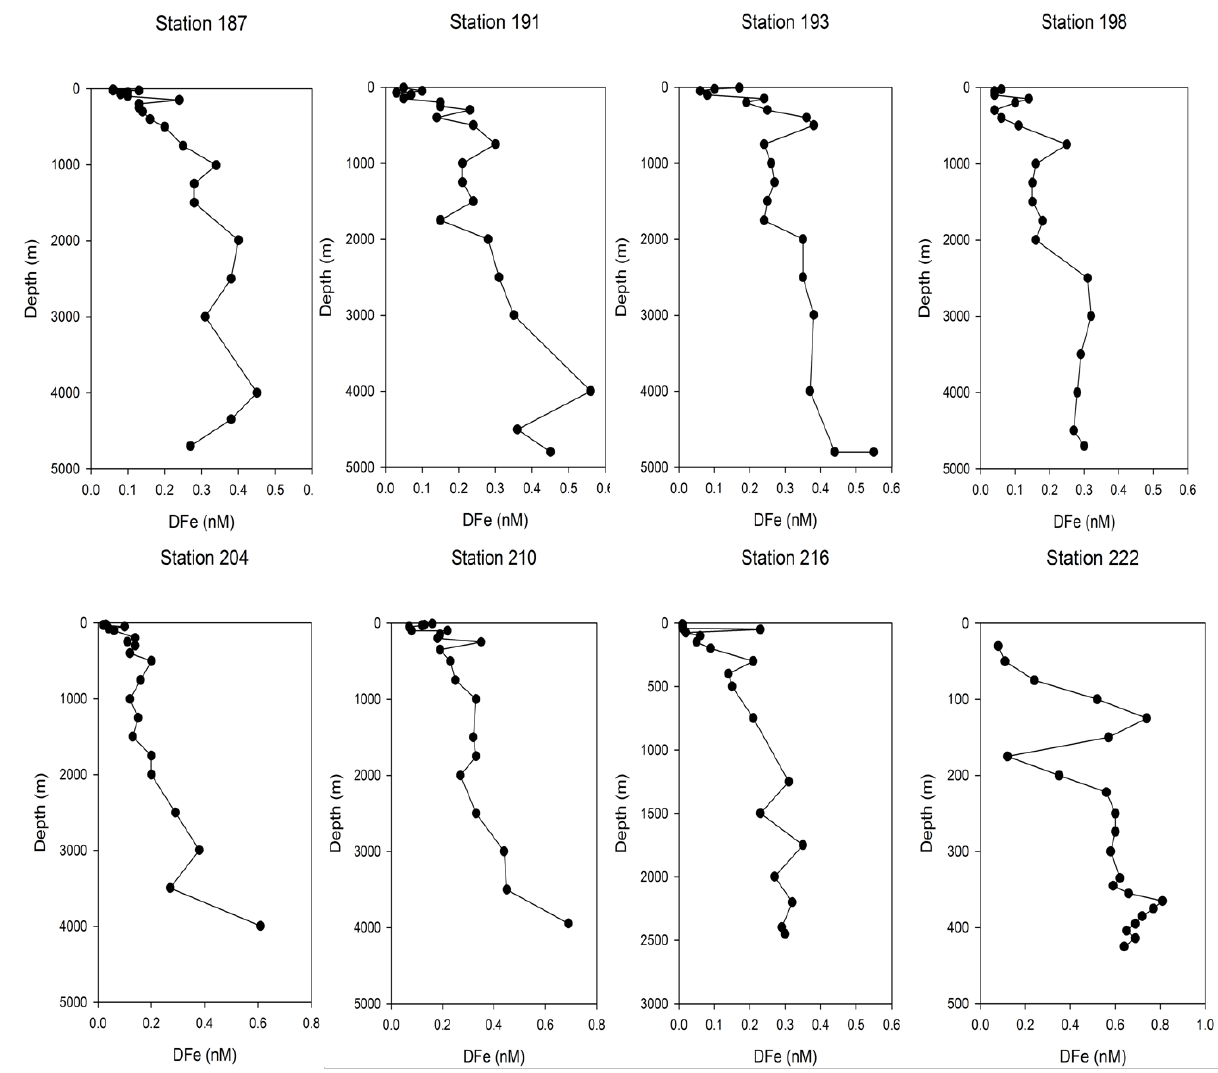
Fig. 4b. Vertical profiles of DFe at individual stations of the transect Weddell Sea. Note the different depth and concentration scale.